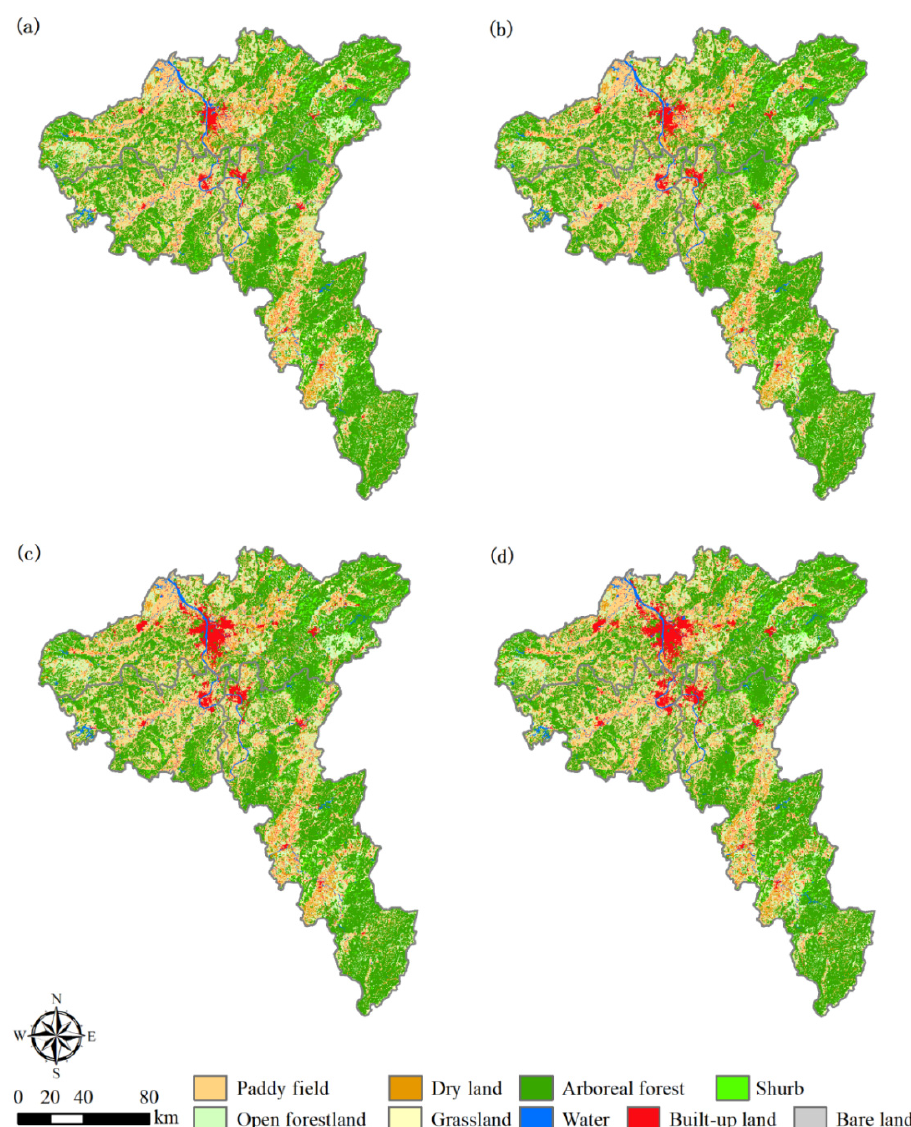
Figure 1. Spatially explicit land-use maps of the CZT urban agglomeration in ( a ) 2000, ( b ) 2005, ( c ) 2010, and ( d ) 2015.